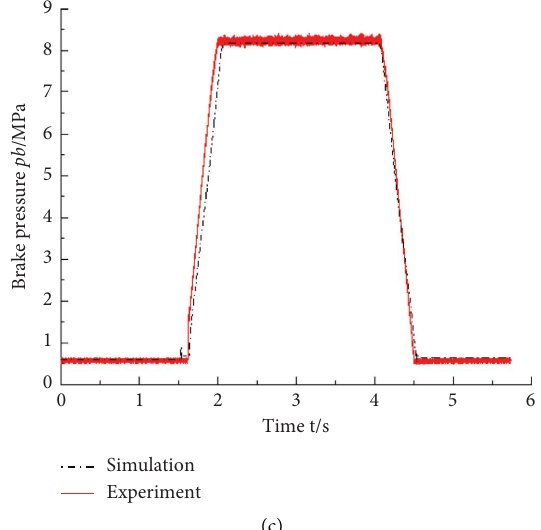
Figure 18: Test results of two-stage brake pressure servo valve. (a) 20mA step current input. (b) 40mA step current input. (c) 40mA ramp current input.